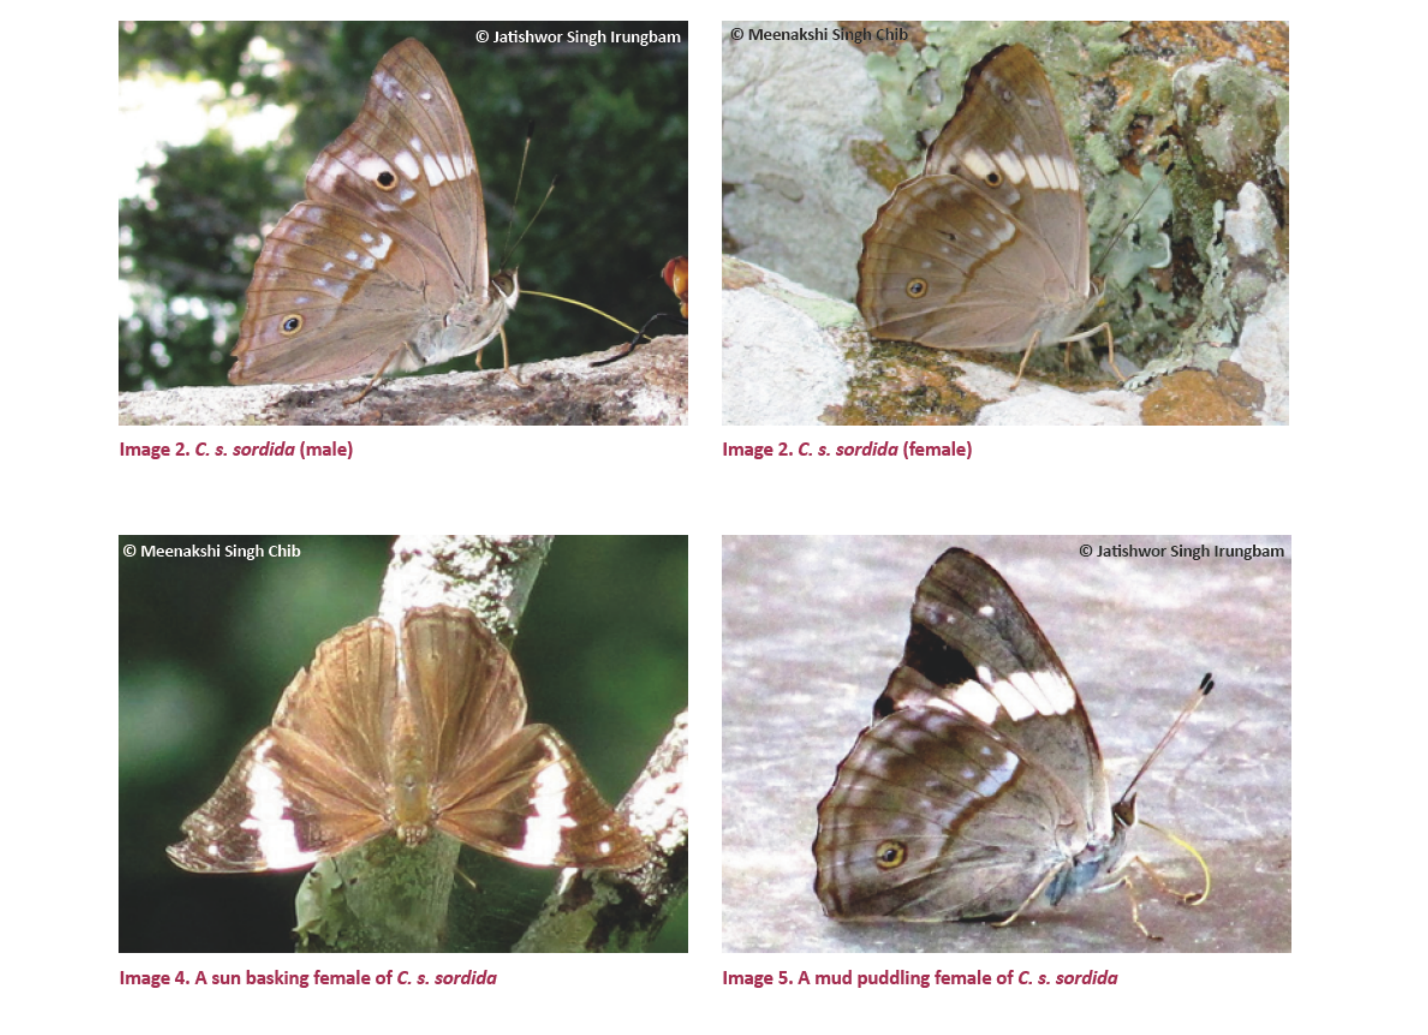
Image 5. A mud puddlfing ffemale off C. s. sordfida